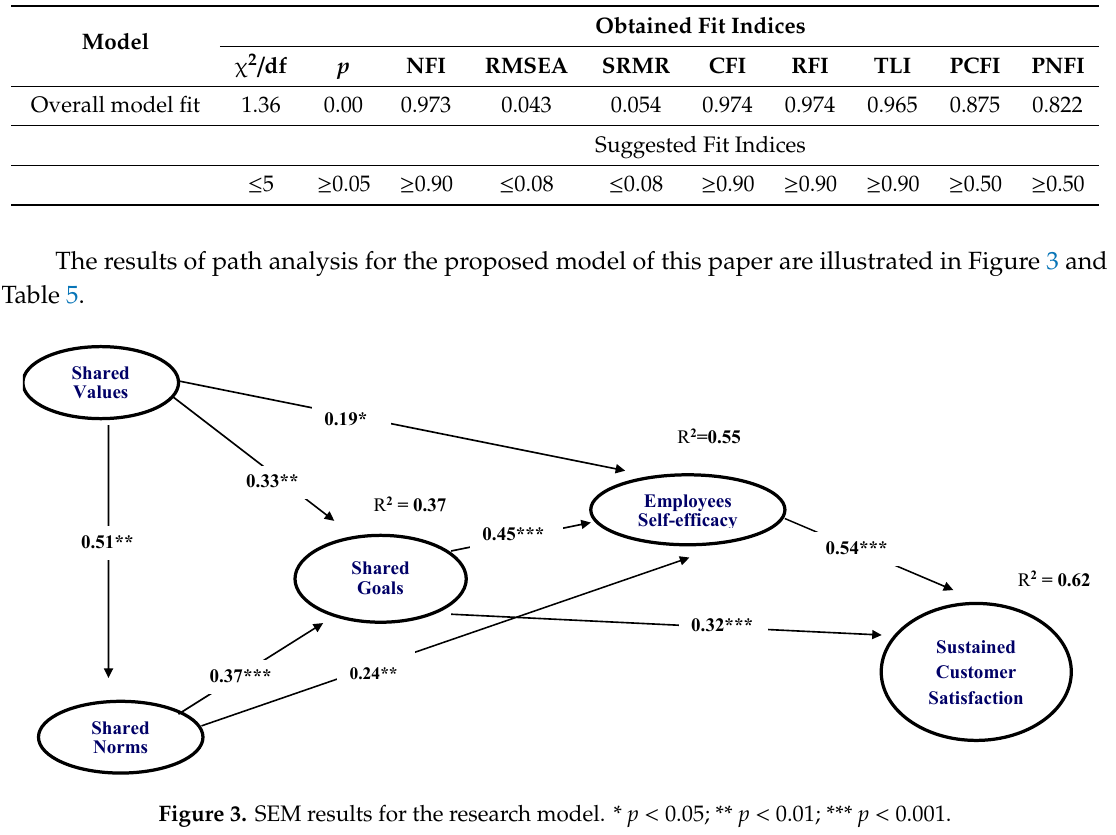
Table 4. Assessment of overall model fit.